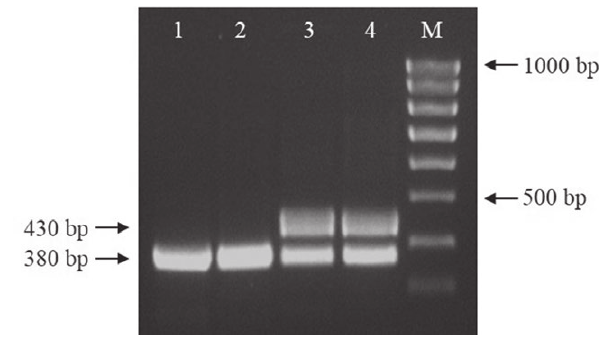
Figure 1. DNA amplification products of tomato ( Solanum lycoper- sicum ) using the Mi23 markers linked to the Mi-1.2 gene. Bands 1, ‘Actimino’; 2, ‘Briomino’; 3, ‘Veinal’; 4, ‘Vimeiro’; M, DNA marker; (Hyper-Ladder IV, Bioline).